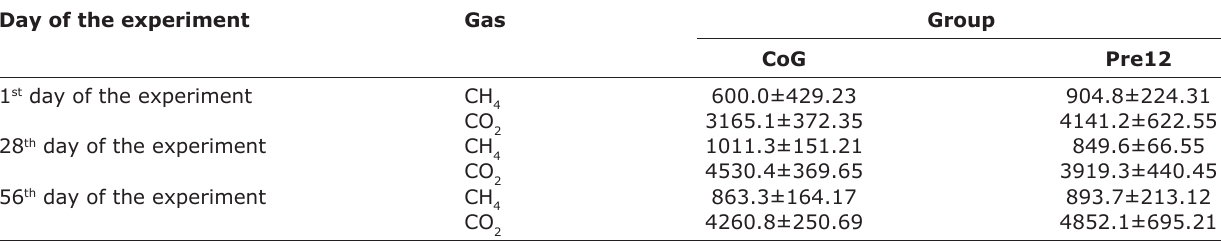
(mg/m 3 ±SD) and CO (mg/m 3 ±SD) in calves’ rumen during the experiment. 4 2